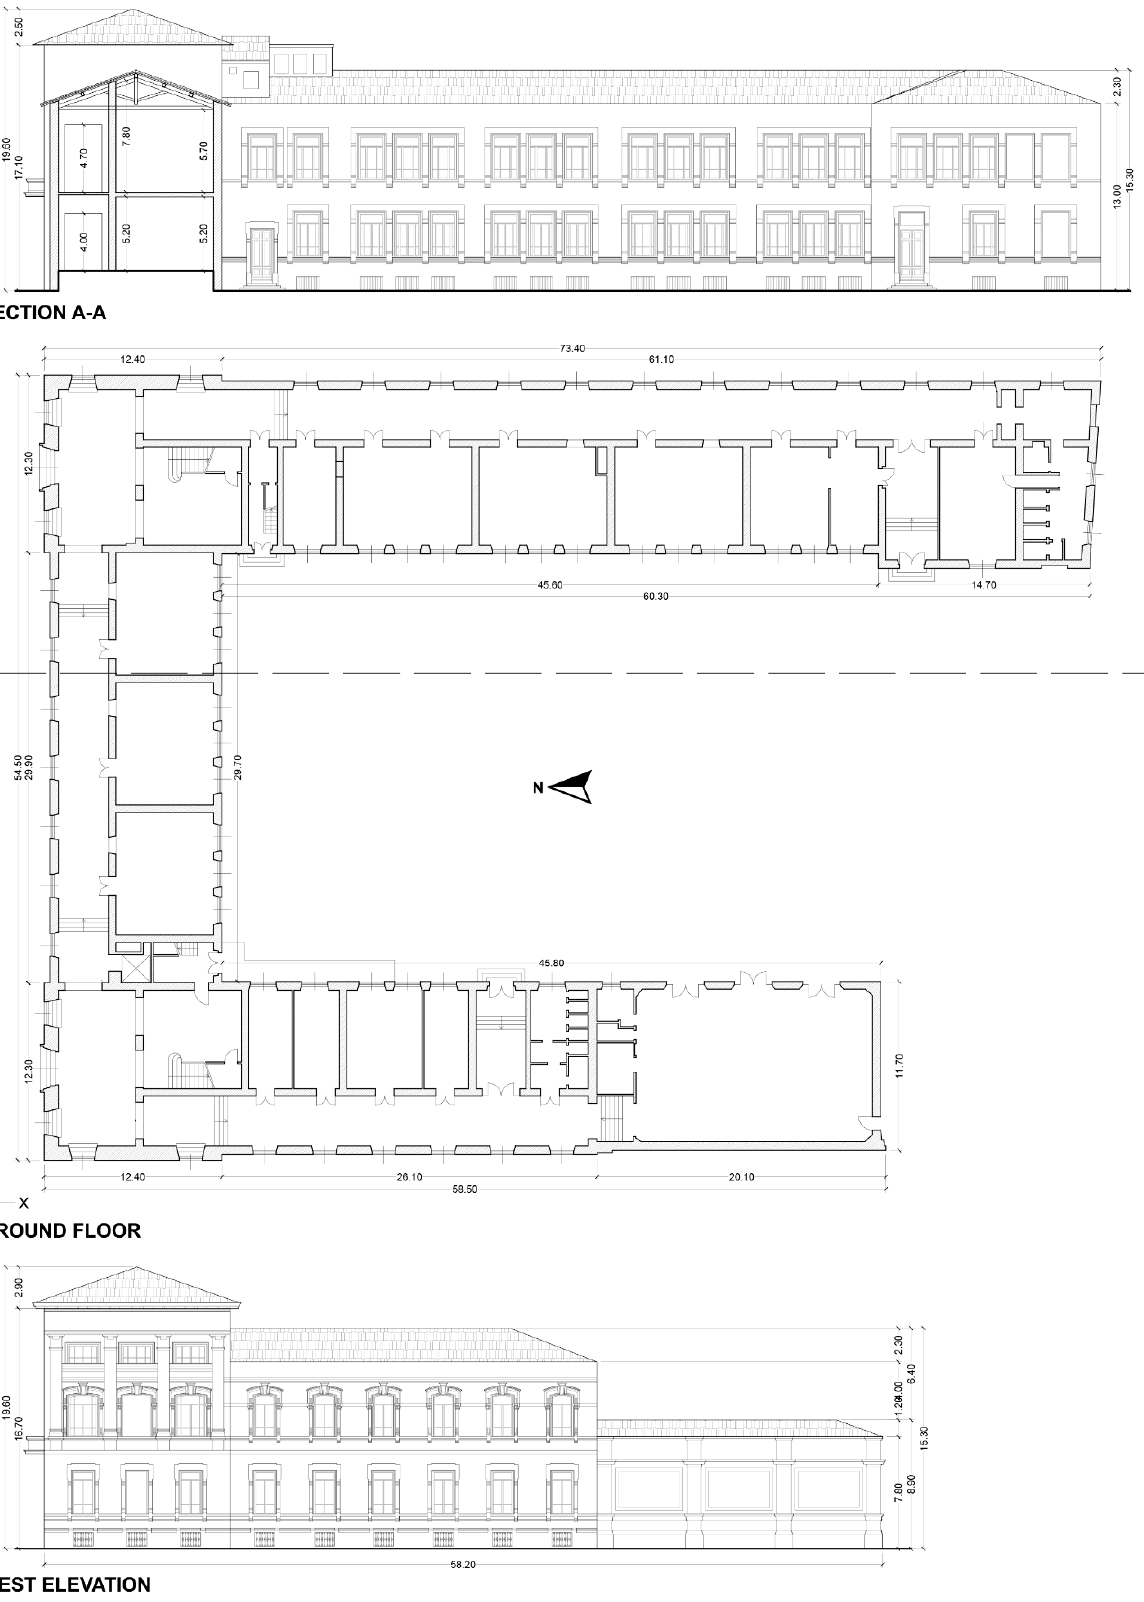
Figure 6. Section A ‐ A, plan layout of the ground floor and west elevation of the secondary school Figure 6. Section A-A, plan layout of the ground floor and west elevation of the secondary school “Machiavelli” (unit: m). “Machiavelli” (unit: